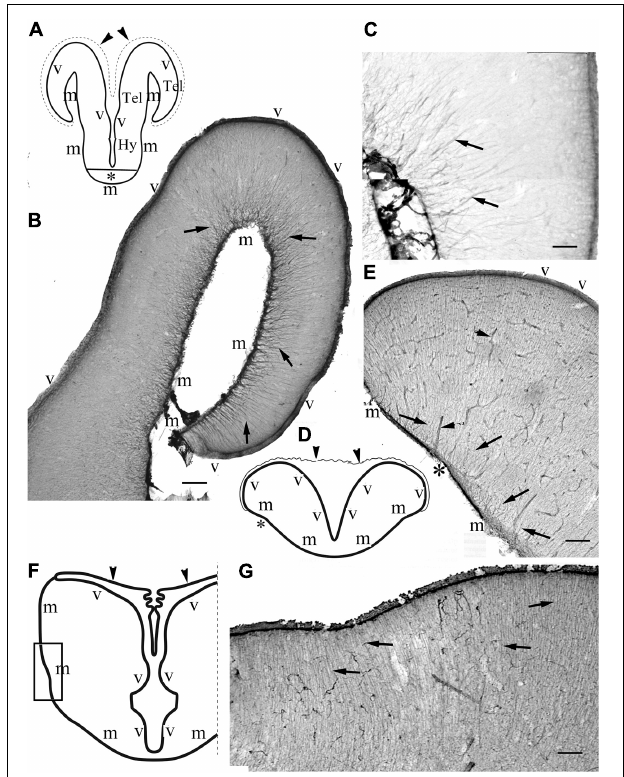
FIGURE 3 | Non-teleost telencephala: the radial glial processes do not converge fan-shaped. (A) Sketch of bichir prosencephalon redrawn after López et al. (2013); m,v: meningeal and ventricular surfaces, Hy, Tel: hypothalamus, telencephalon; arrowheads and dotted line: the epithelial roof of ventricle and the choroid plexus (in the photomicrographs it is torn, not visible); asterisk: optic chiasma. (B) Bichir telencephalon, m,v: meningeal and ventricular surfaces. Arrows: radial glia. Scale bar:100 µ m. (C) Bichir telencephalon, enlarged detail. Arrows: radial glia. The processes are almost parallel, do not converge. They cannot be followed to the ventricular surface Scale bar: 40 µ m. (D) Sketch of sterlet telencephalon redrawn after Nieuwenhuys (1997b), with the position of panel (E) , see asterisk; m,v: meningeal and ventricular surfaces; arrowheads: the epithelial roof of ventricle, and the choroid plexus. (E) Sterlet telencephalon. m,v: meningeal and ventricular surfaces. Arrows: radial glia, the thick lines (arrowheads) are vessels, asterisk is positioned as in panel (D) . The meningeal ends of the radial processes show some convergence but do not gather to a common center. Scale bar: 100 µ m. (F) Sketch of gar telencephalon redrawn after Parent and Northcutt (1982), with the position of panel (G) ; m,v: meningeal and ventricular surfaces; arrowheads: the epithelial roof of ventricle, and the choroid plexus. (G) Lateral detail of a gar telencephalon. The panel has been turned to right, for the correct position see panel (F) . Arrows: end-parts of glial processes arriving to the meningeal surface parallel to each other. Scale bar:100 µ